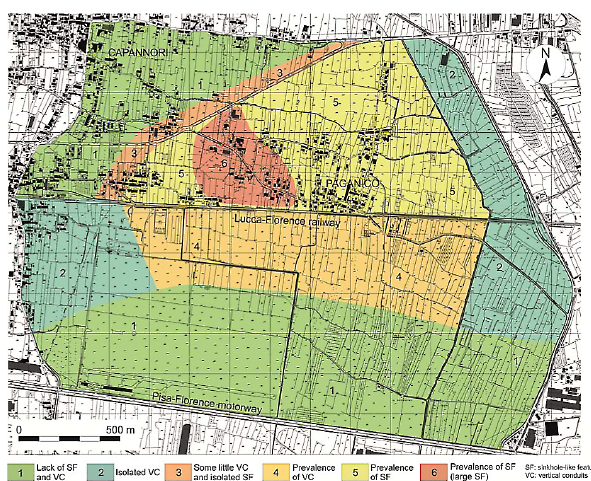
Fig. 6. An example of deep soil cracks affecting clay deposit near Paganico (the scarp is approximately 2m high). Fig. 7. Distribution of the sinkhole-like features in the Paganico